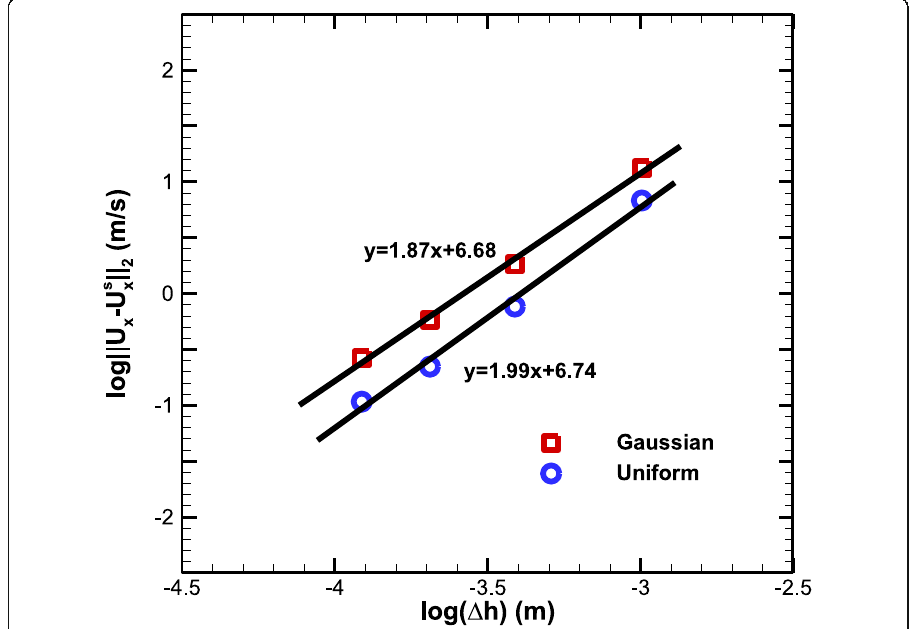
Fig. 4 L 2 -norm of the U x -errors for the efficient USP-BGK method in the Taylor-Green vortex flow depended on the cell size, and Δ h ∈ {1/50, 1/40, 1/30, 1/20} (m). The uniform and Gaussian kernel